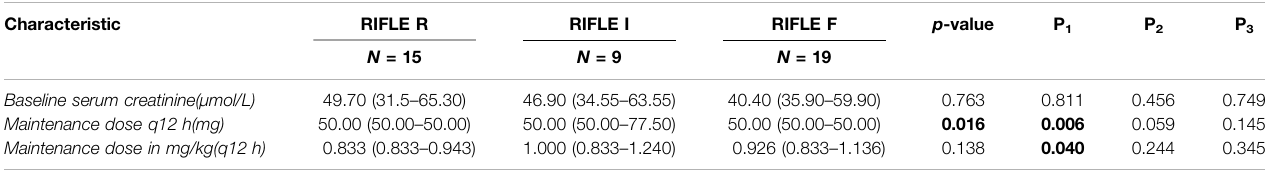
RIFLE (Risk, Injury, Failure, Loss of kidney function, and End-stage renal disease) criteria. p -value, the comparison of three groups; P 1 , RIFLE R vs. RIFLE I; P 2, RIFLE R vs. RIFLE F; P 3, RIFLE I vs. RIFLE F. Bold font indicates data with signi fi cant differences.